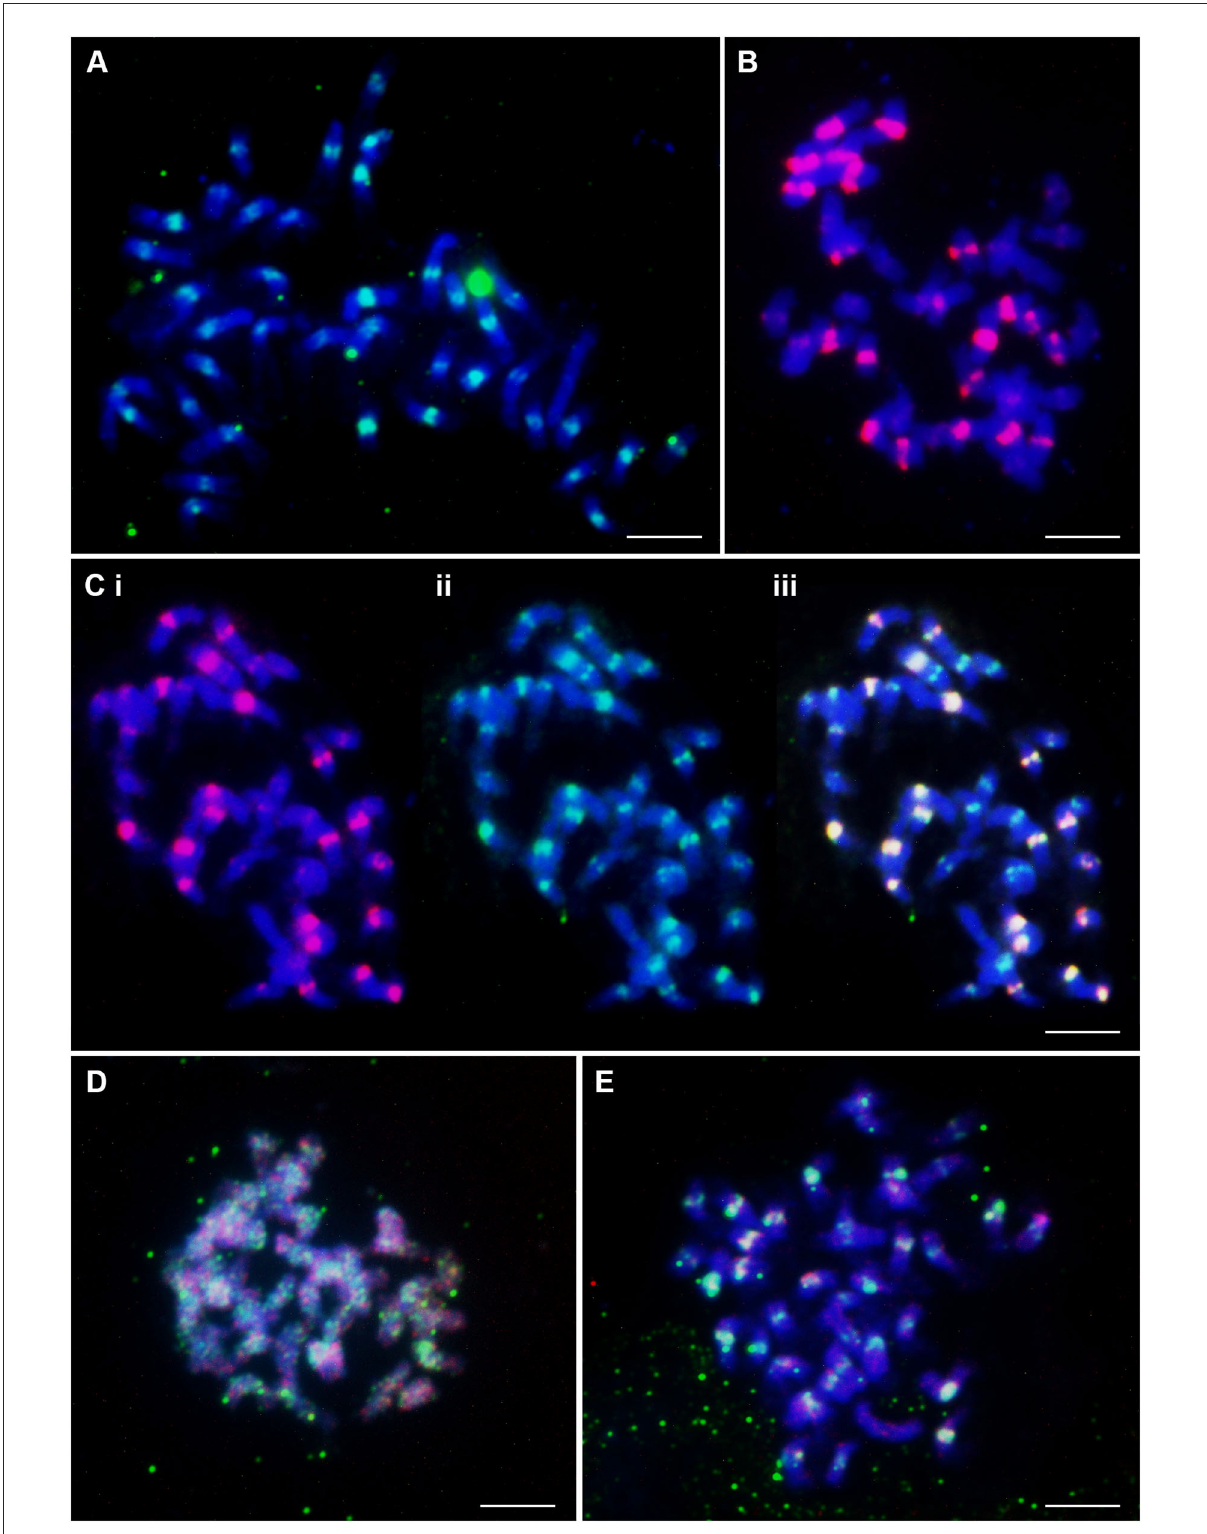
FIGURE3 Distribution of highly abundant repetitive DNA motifs on chromosomes of C. ciliaris (2 n = 4 x + 3 = 39). (A) Tandem repeat CenchEnCL1ConsRC probe labeled with FAM (green) showed strong signals in pericentromeric regions of about half of the chromosomes. The